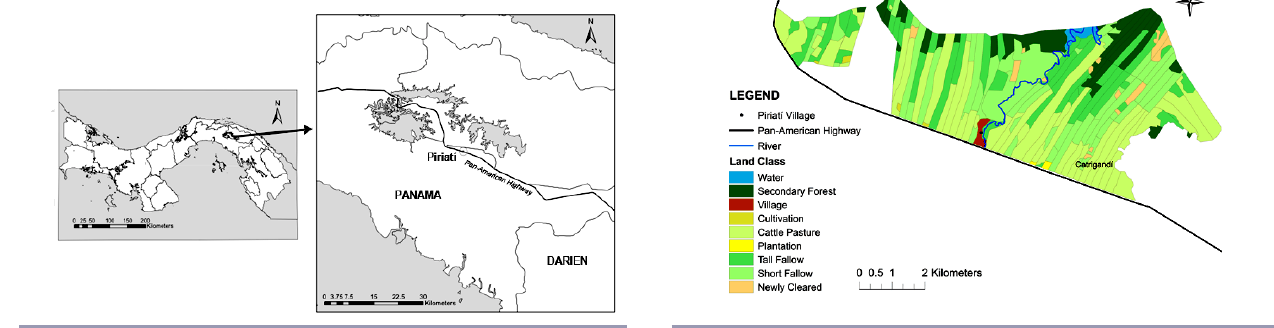
Fig. 1 . Location of the indigenous community of Piriatí- Emberá in eastern Panama.